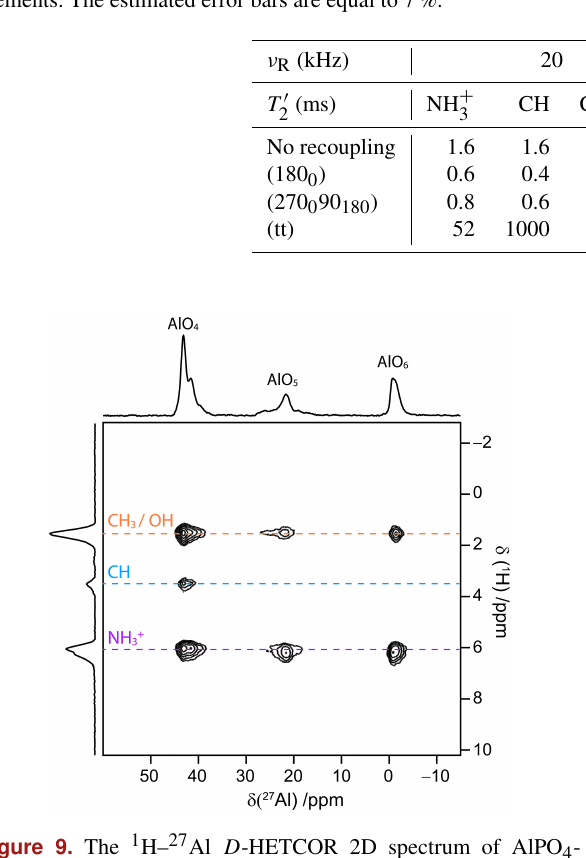
(270 0 90 180 ) trans- 1